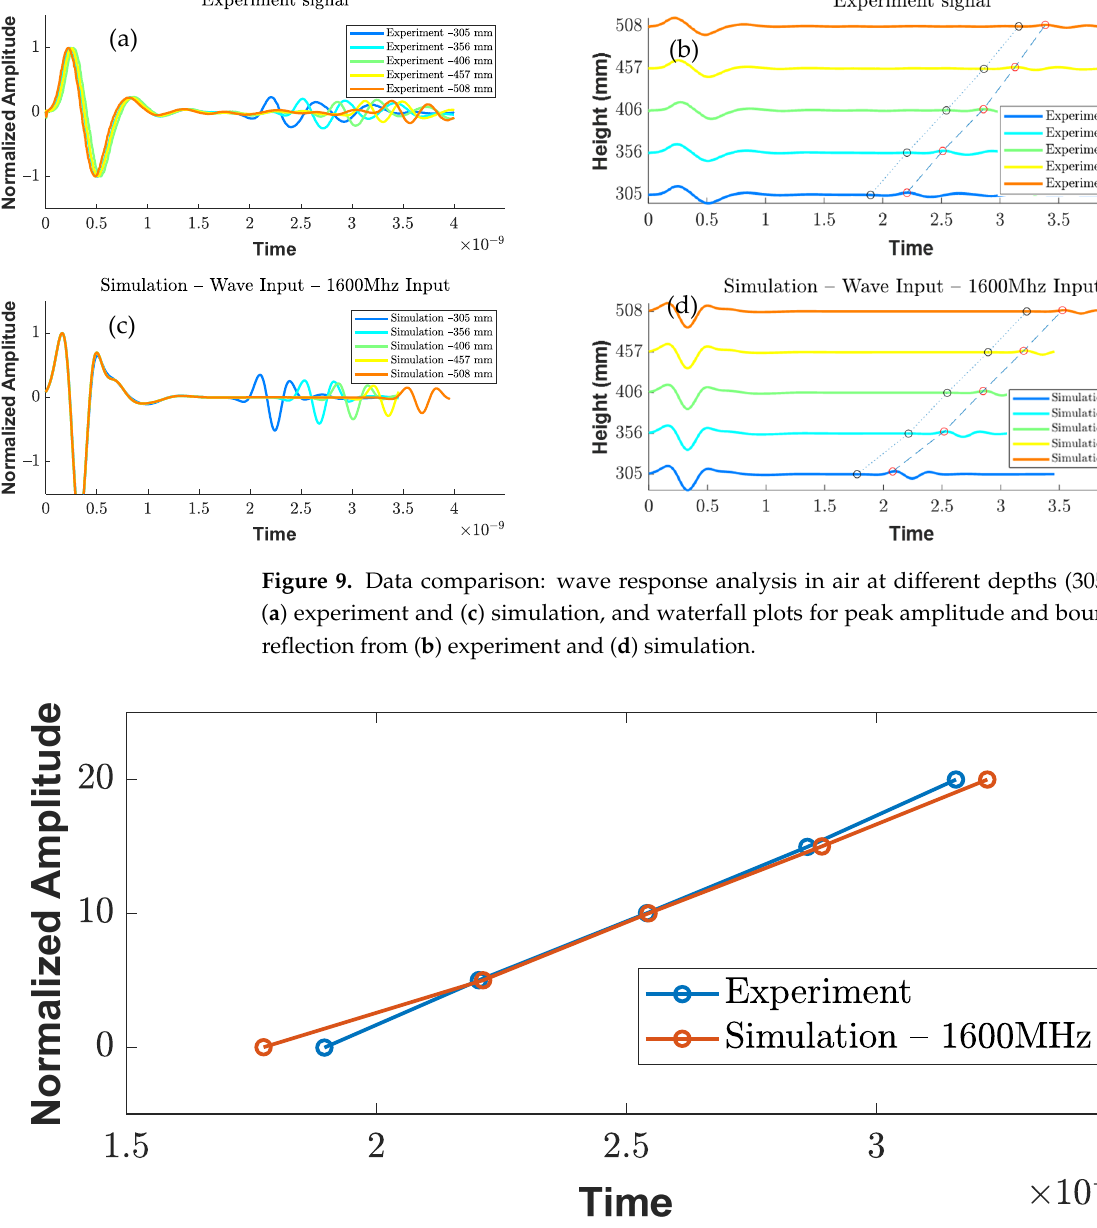
Figure 10. Comparison of slope lines similarity between simulation and experiment.